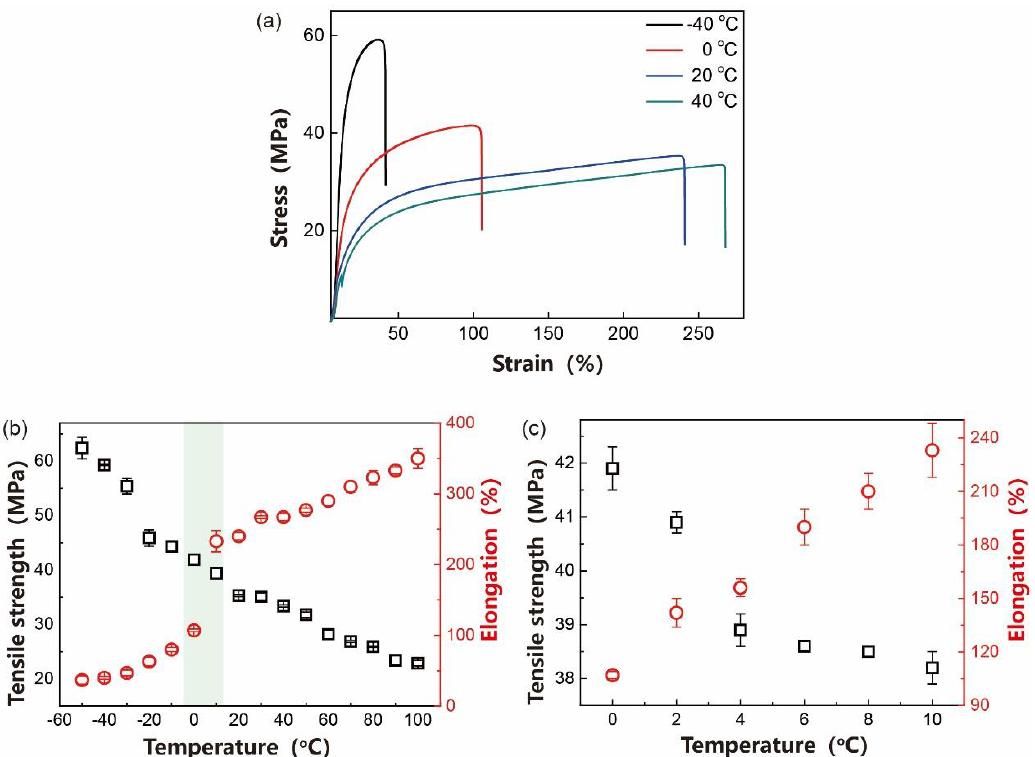
Figure 6. ( a ) The stress strain curves at −40 °C, 0 °C, 20 °C and 40 °C. ( b , c ) The temperature dependence of tensile strength and elongation for fuel pipes in the temperature range of −50–100 °C ( b ) and 0–10 °C ( c ).